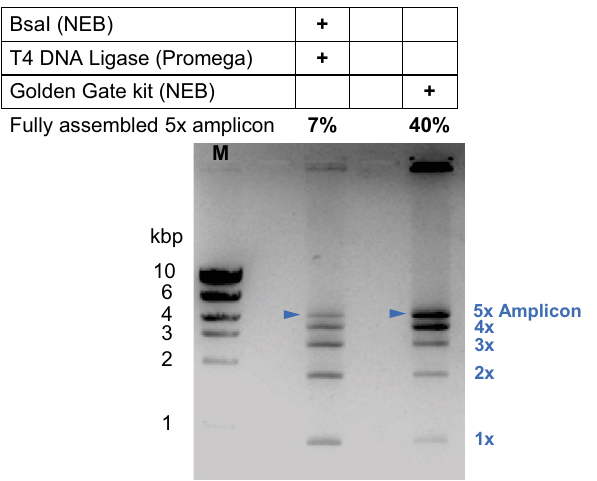
Figure 2. An example agarose gel showing the efficiency of concatenation for library variants 1–5 using enzymes from different commercial sources. Performance was quantified for each reaction by the percentage of fully assembled 5 × amplicon (marked by blue triangles). The NEB Golden Gate assembly kit was shown to concatenate the library variants more efficiently, increasing the amount of fully assembled product to 40%. A more detailed comparison can be seen in the Supplementary Fig. S2.